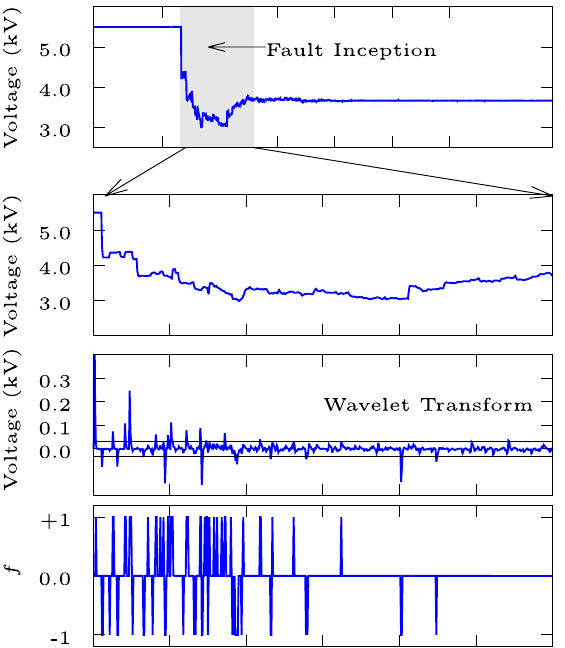
Figure 11. Demonstration of the proposed method for node C20 and R f = 10 Ω . The wavelet transformed fault signal is compared to a threshold value and converted into a “barcode”, which is subsequently compared with E to find the highest